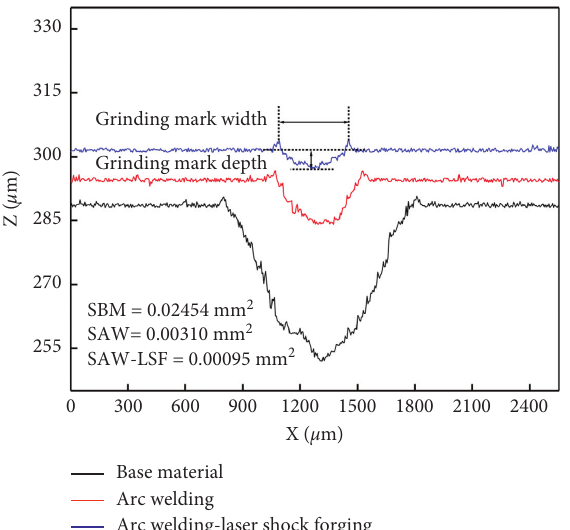
Figure 10: The cross-sectional profile of the grinding marks measured along the red lines is marked in Figure 9. Grinding mark width: distance between the highest point of the two rims. Grinding mark depth: distance between the surface of the substrate and the lowest point of the grinding mark. The SBM, SAW, and SAW-LSF are the cross-sectional areas of the grinding mark formed by the BM, the AW cladded layer, and the AW-LSF cladded layer, respectively.